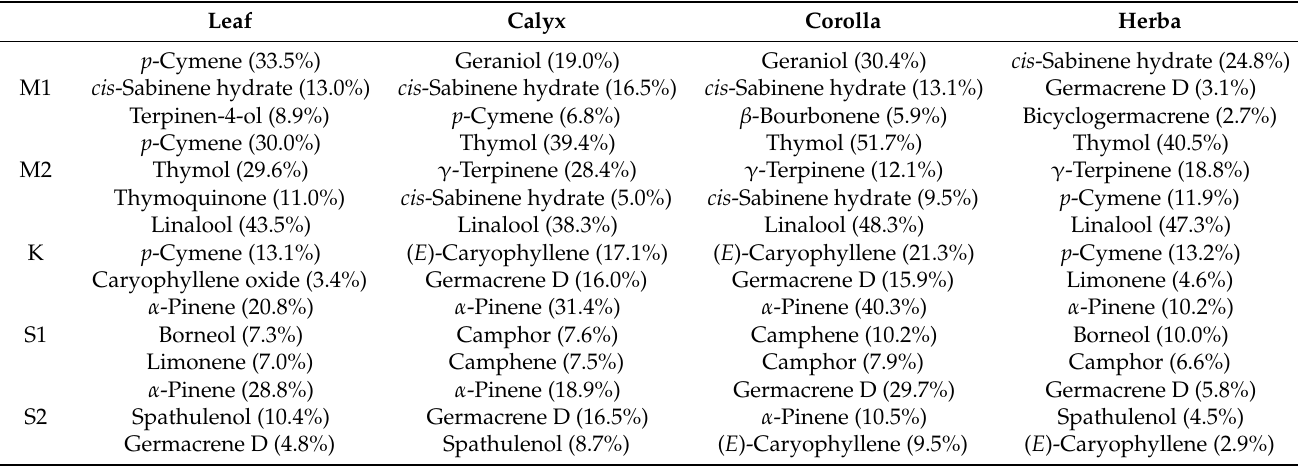
Table 3. Three most abundant compounds in the plant part and herba essential oils (EOs) of Satureja montana , S. kitaibelii , and S. subspicata . The list of all compounds in their elution order is given in Table S2.